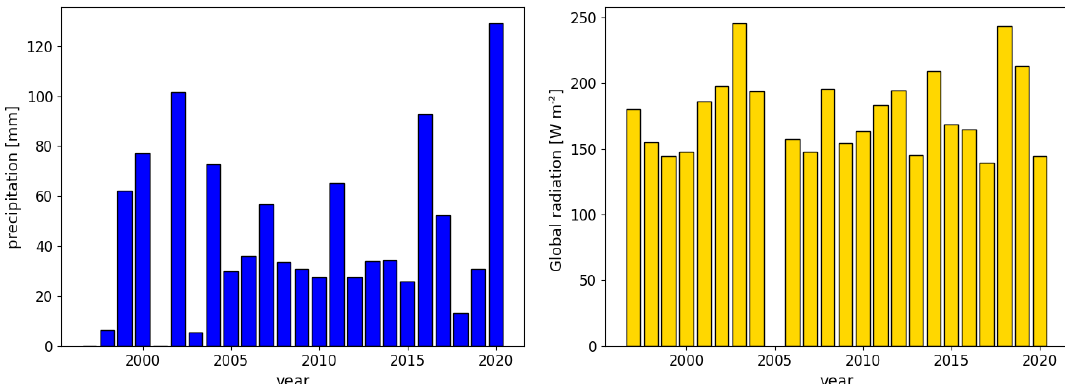
Figure A3. Time series of the monthly accumulated precipitation and mean solar irradiance between 10:00 and 14:00UTC at the Wettermast Hamburg for February from 1997–2020.